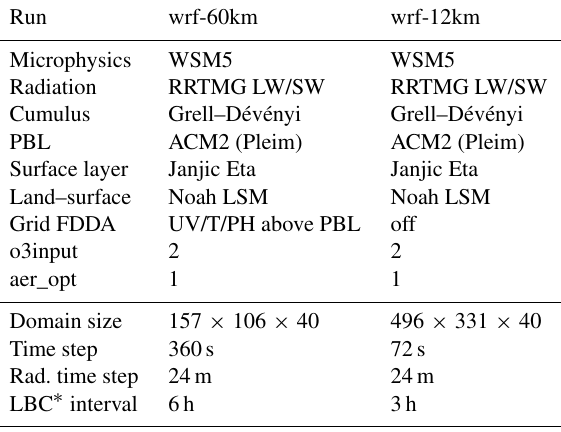
Table 4. WRF model configuration for the two domains at 60 and 12km